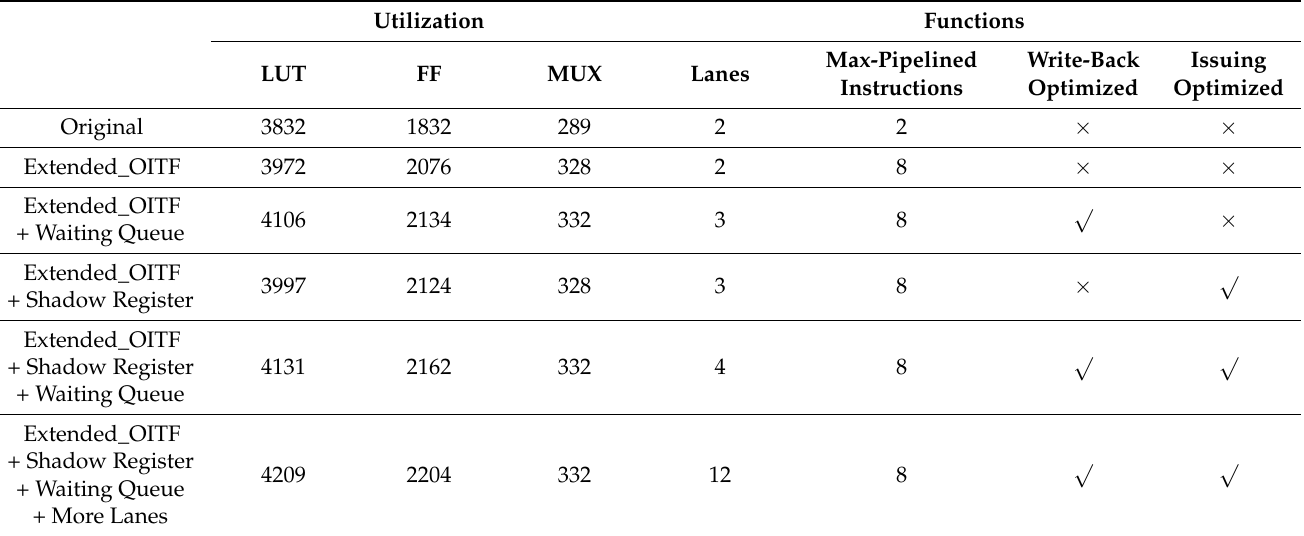
Table 2. Extending the depth of OITF to 8, the table contains the experimental data in applying optimized designs to the original design. For example, when extending the instruction stream lanes to 12 with full functions, the consumption of look up table (LUT) is 4209, flip-flop (FF) is 2204 and multiplexers (MUX) is